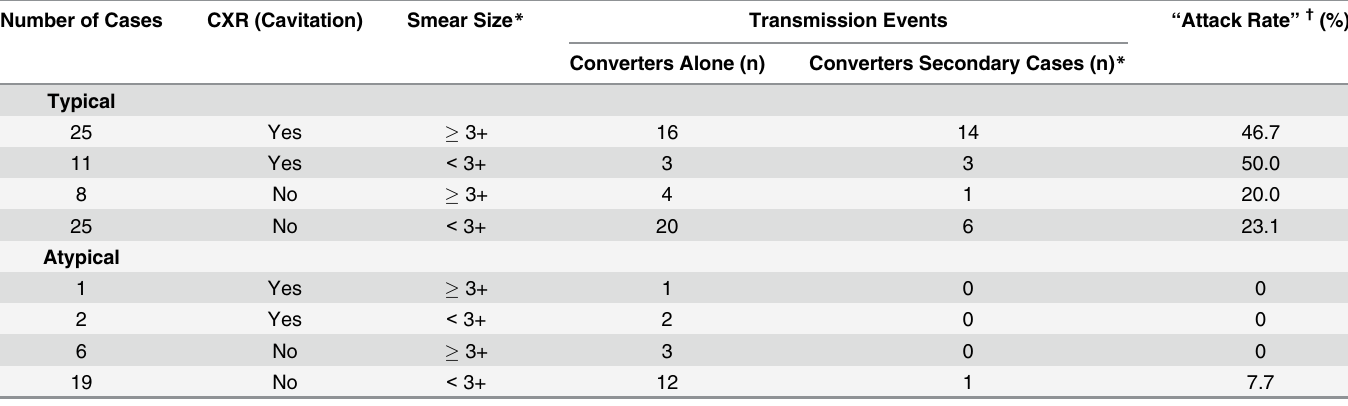
Table 5. Transmission Events in Close Contacts of “ Typical ” and “ Atypical ” Pulmonary TB Cases grouped according to Radiographic Appear- ance (Cavitary or Non-Cavitary) and Sputum Semi-quantitative Smear Size.